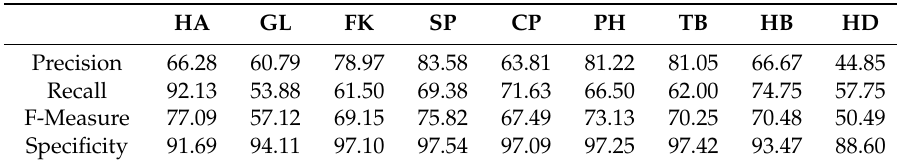
Table A2. Values of precision, recall, F-Measure, specificity of LOSO model SVM W (all values are expressed in %).